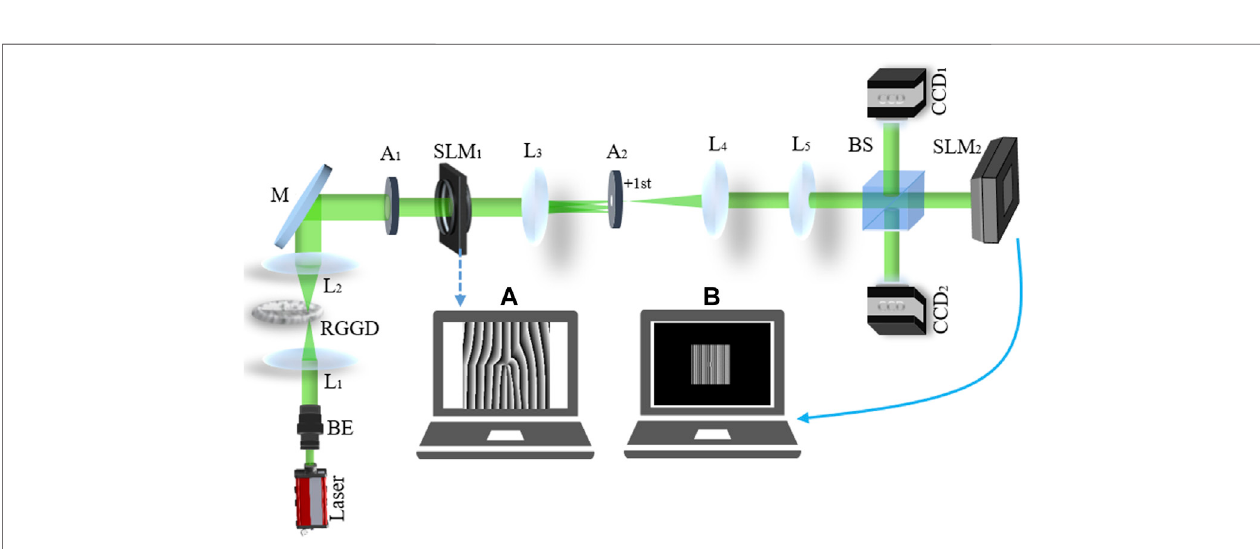
FIGURE3| Experimental setupforgeneratingaPC-PEPVbeamandmeasuringtheamplitudeandphasedistribution ofitsCSD. (A) ForkgratingwrittenintoSLM 1 and (B) phase mask written into SLM 2 . BE, beam expander; L 1 – L 5 , lenses; RGGD, rotating ground-glass disk; M, mirror; A 1 , A 2 , apertures; SLM 1 , SLM 2 , spatial light modulators; BS, beam splitter; and CCD 1 , CCD 2 , charge-coupled device.